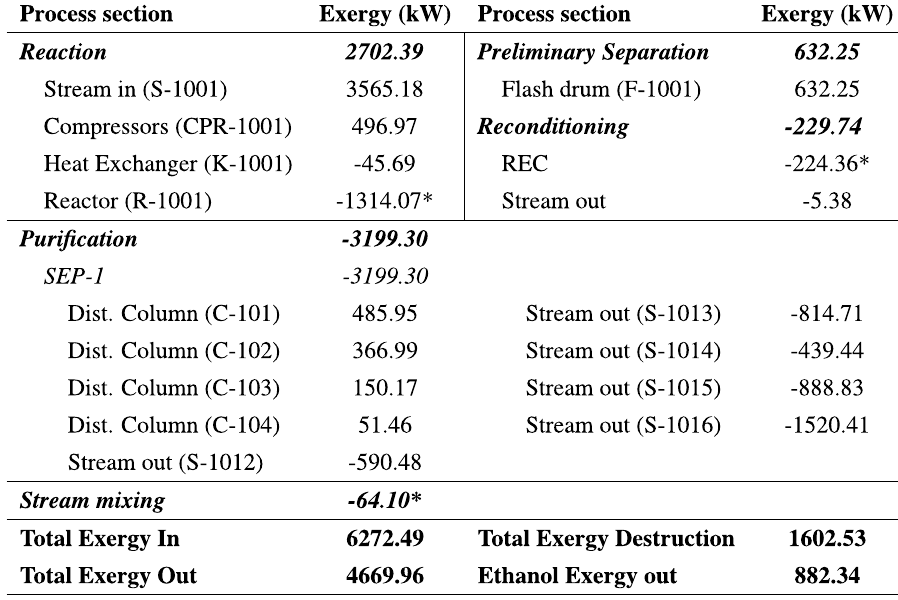
Table 2 Exergy quantification in each section of P-2